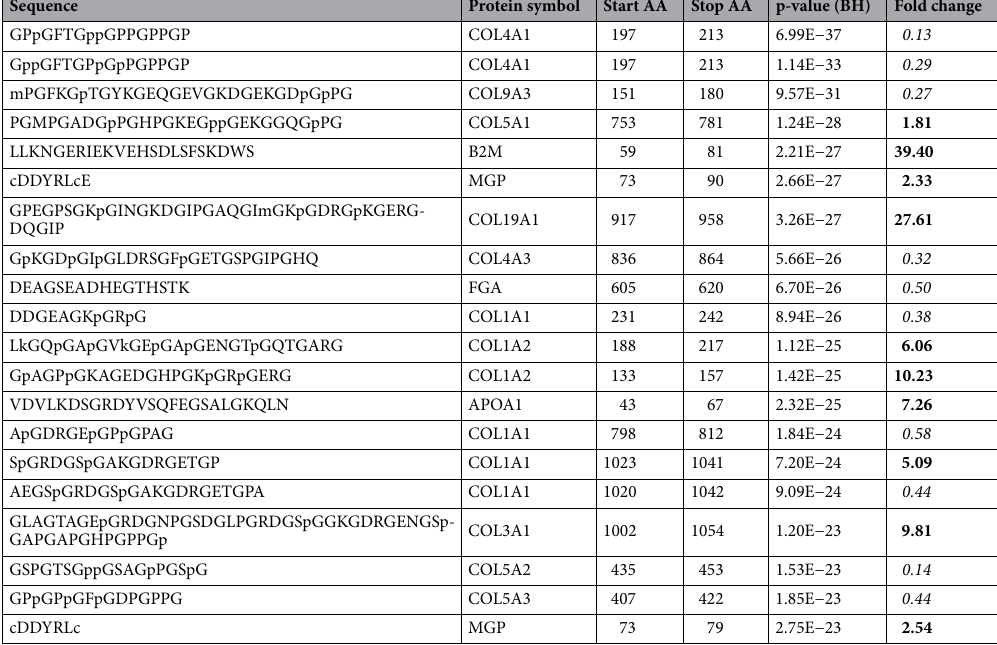
Table 2. List of the 20 top most significant differentially excreted CRS peptides. Peptides increased in CRS are labelled in bold, decreased in italics. AA: amino acid; BH: